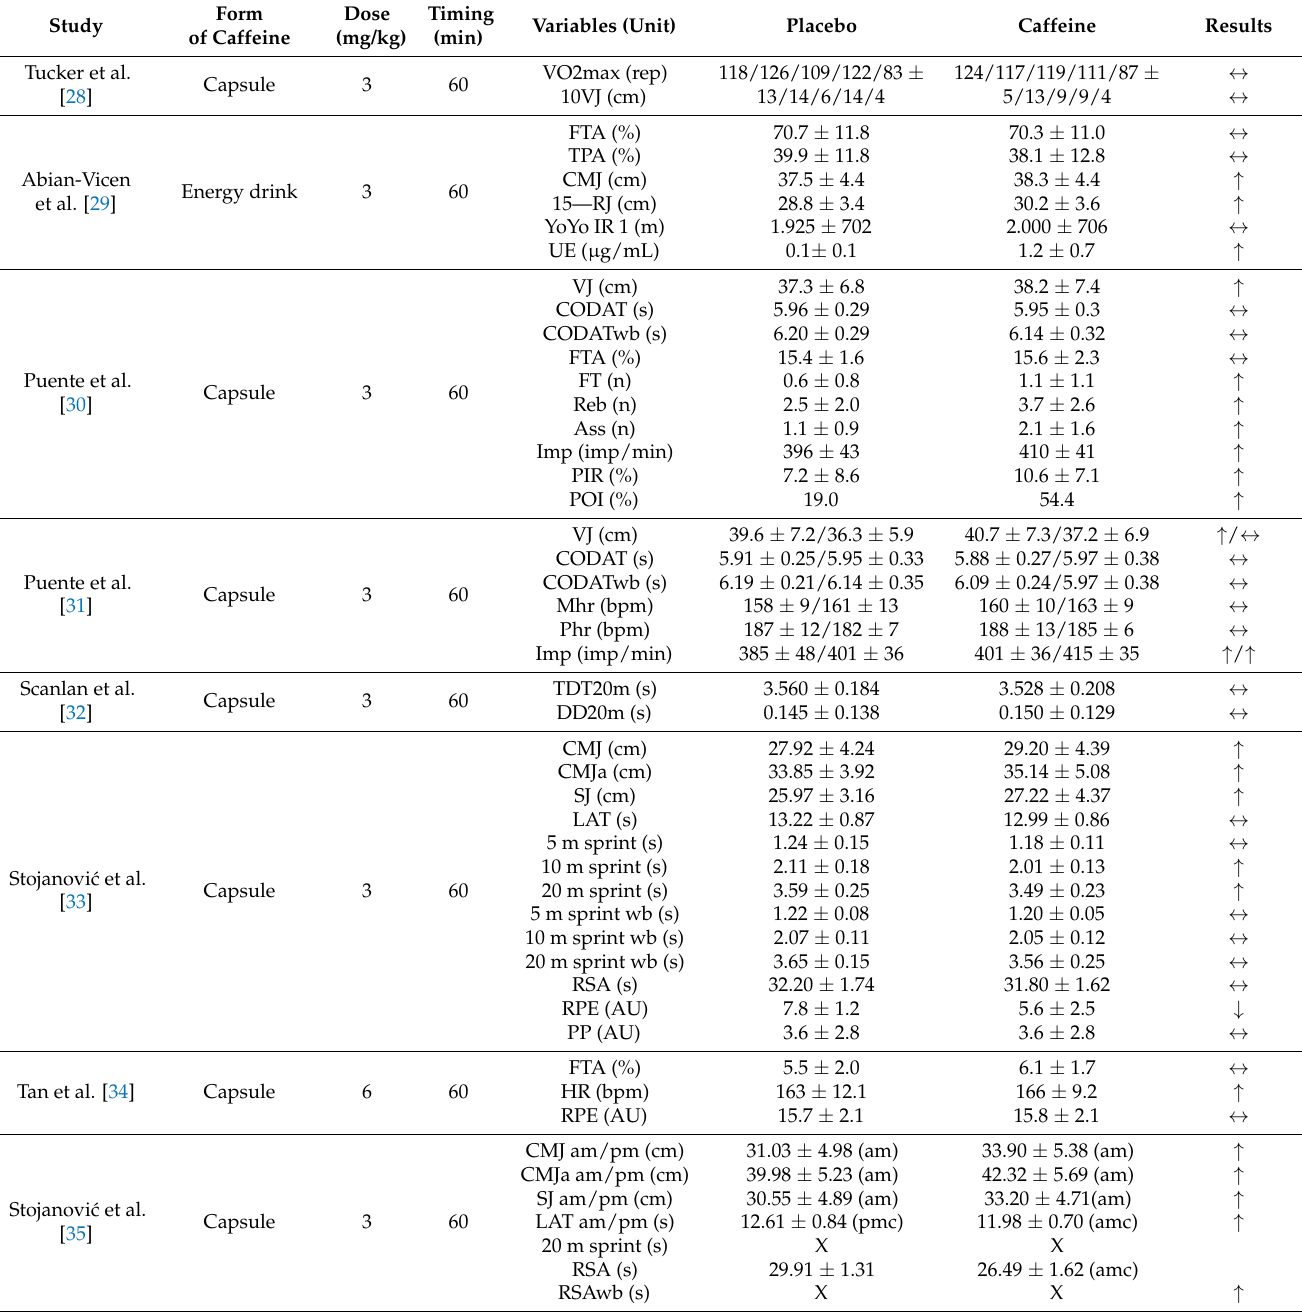
Table 2. Experimental program of acute caffeine ingestion in basketball